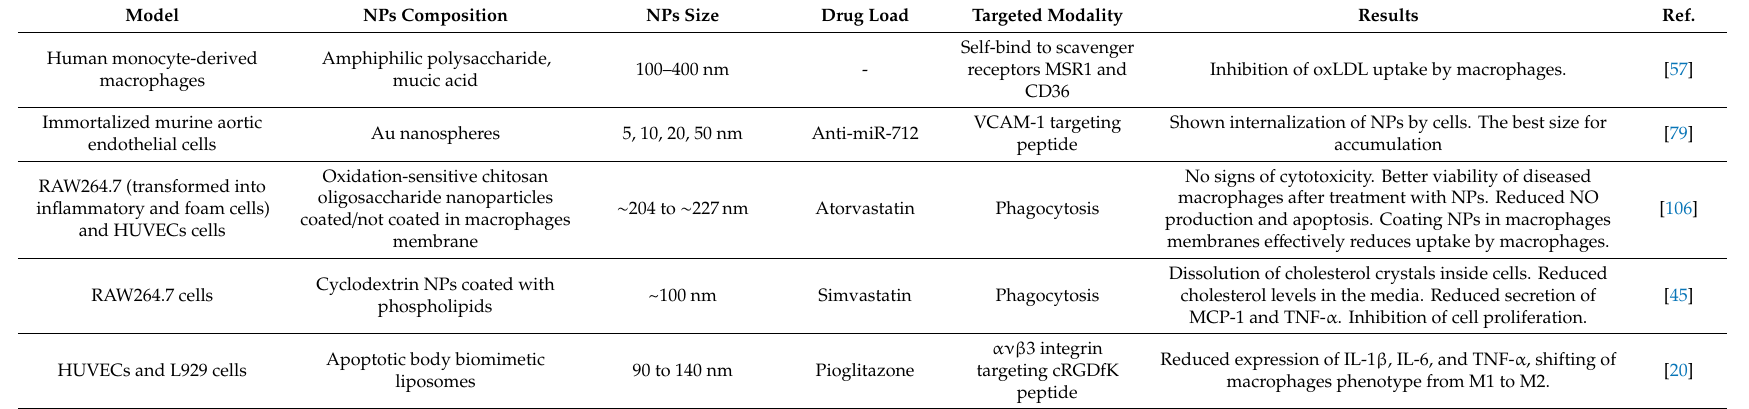
Table 1. Nanoformulation with in vitro proved e ffi